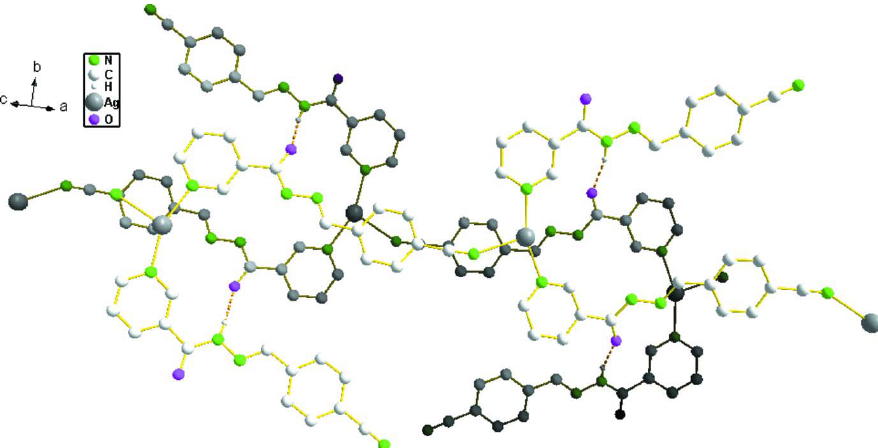
Figure 3 A diagram showing the intermolecular hydrogen bonds indicated by dashed lines. All counteranions and H atoms not involved in hydrogen bonds have been omitted for